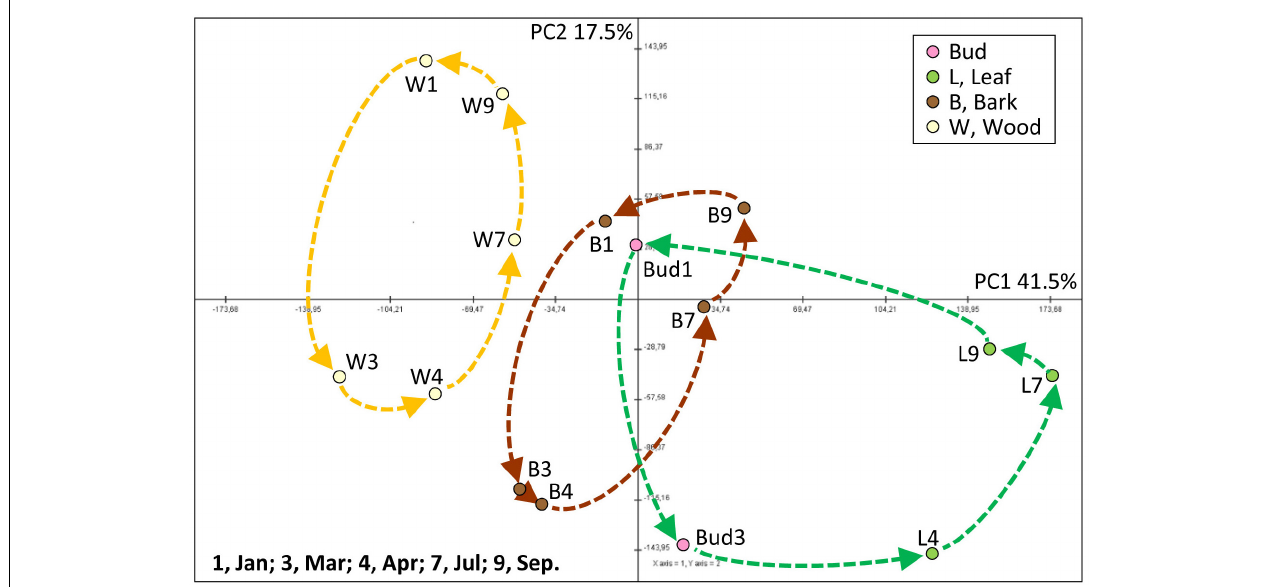
FIGURE 2 | Principal component analysis (PCA) score plot of metabolite levels in buds/leaves, twig bark, and wood of adult poplar trees during annual growth. The plots were applied for 85 annotated metabolites including primary metabolites detected by GC/TOF-MS, ions by ion chromatography, amino acids and thiols by HPLC, and soluble protein by a Bradford method. PCA was conducted by the Multi Experiment Viewer (Saeed et al., 2003). PC, principal component. Data represent mean values of five biological replicates for each tissue at each time point.